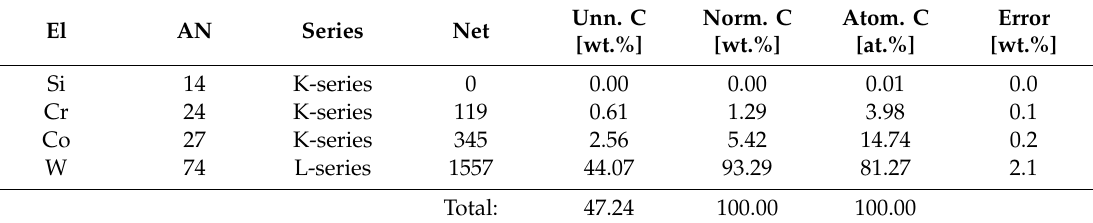
Table 6. The elemental contents of the EDS multi-point sampling area (used